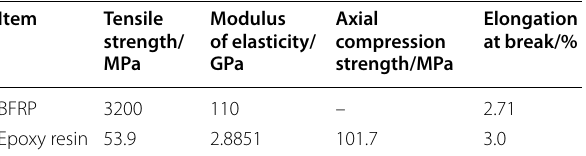
Table 2 Moisture content of poplar